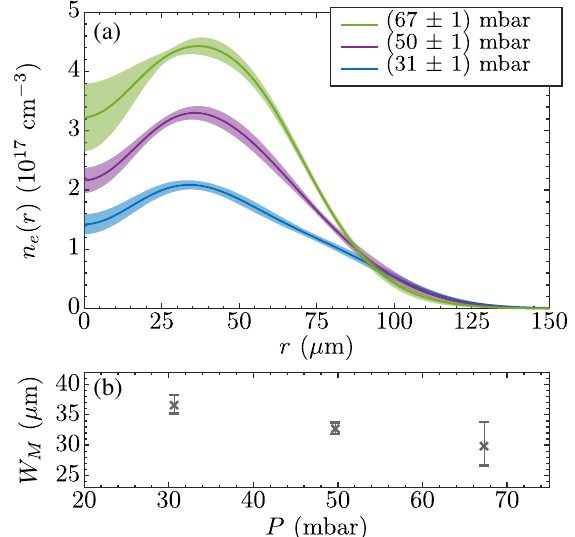
FIG. 2. (a) Deduced electron density profiles of HOFI channels for several initial fill pressures and τ ¼ 3 . 0 ns. For each plot the light bands show the standard deviation obtained from averaging approximately 10 shots. (b) Variation of the measured matched spot size W M with fill